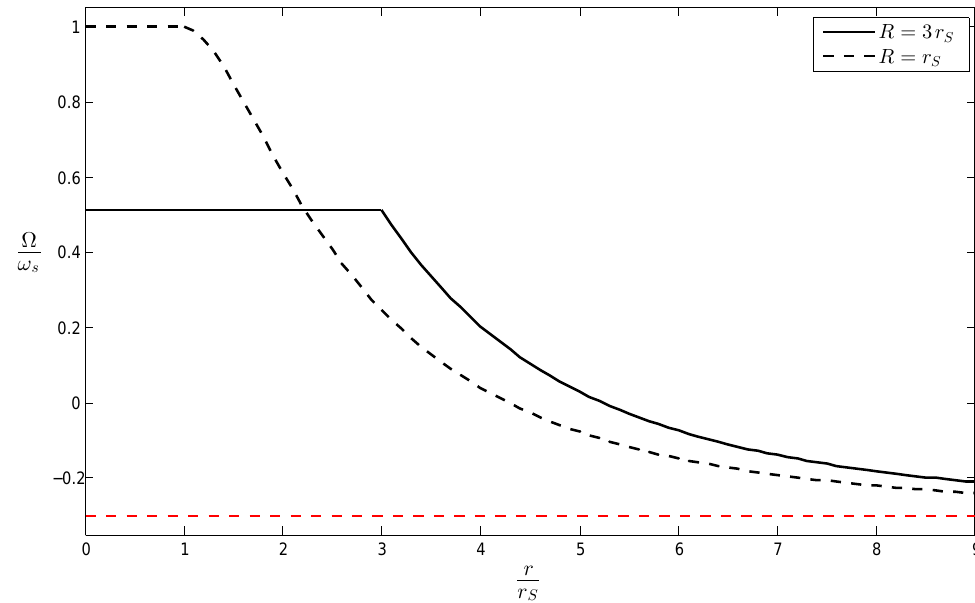
Figure 2. Same parameter values as in Figure 1, except that here r Q → ∞